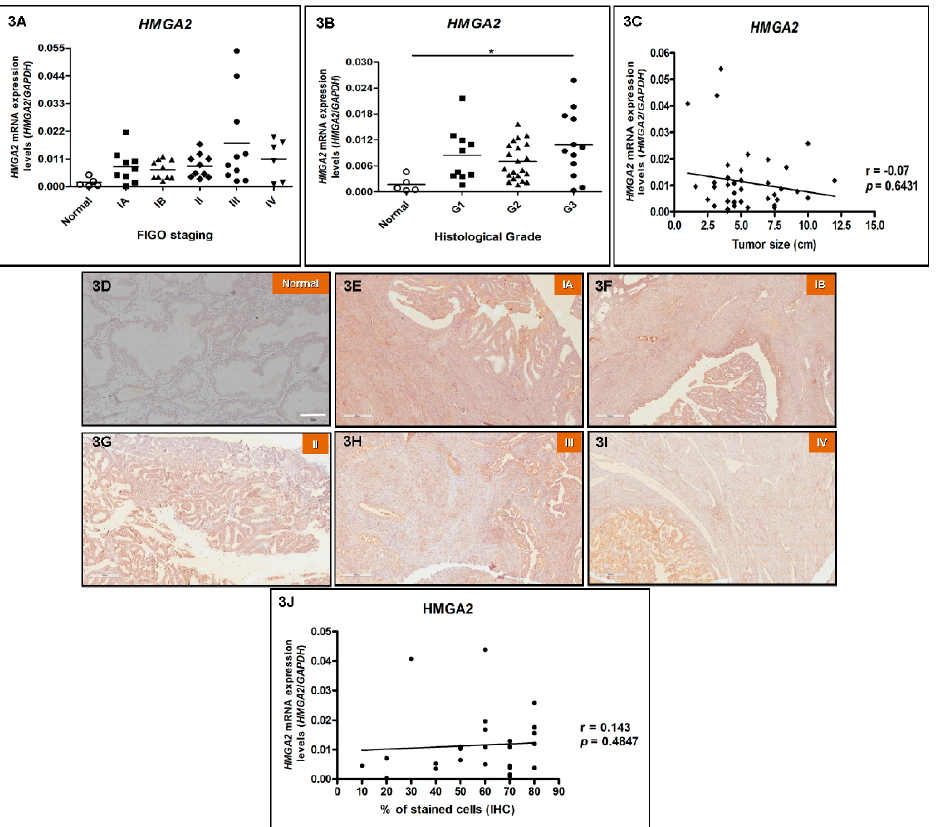
Figure 3. HMGA2 mRNA and protein expression pattern in endometrioid endometrial Figure3.